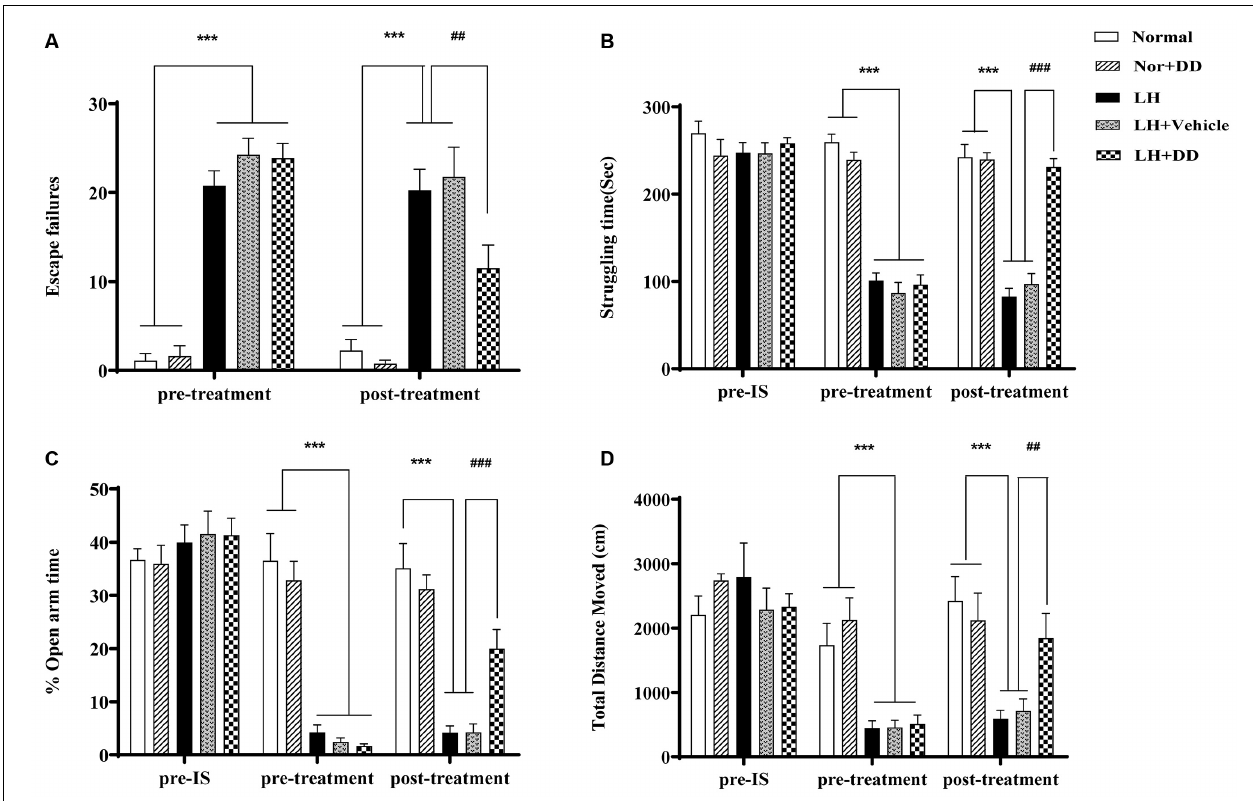
FIGURE 2 | Sub-chronic administration of daidzein was sufficient to alleviate inescapable shock- induced helpless behaviors in LH rats. (A) Inescapable shock significantly increased the number of escape failures during the shuttle-box test. Daidzein alleviated an inescapable shock-induced deficit in escape behaviors. (B) After being exposed to inescapable shock, helpless rats showed even less struggle compared with the normal group, which could be improved by the daidzein treatment. (C) The percentage of the duration spent on the open arms of the elevated plus-maze was more significantly reduced after inescapable shock in the helpless rats compared with the normal group rats, similarly, which could be ameliorated by the daidzein treatment. (D) The total distance rats moved in the open field test (OFT) was also significantly decreased in the helpless rats compared with the normal group rats, in the same way, which could be perfected by the